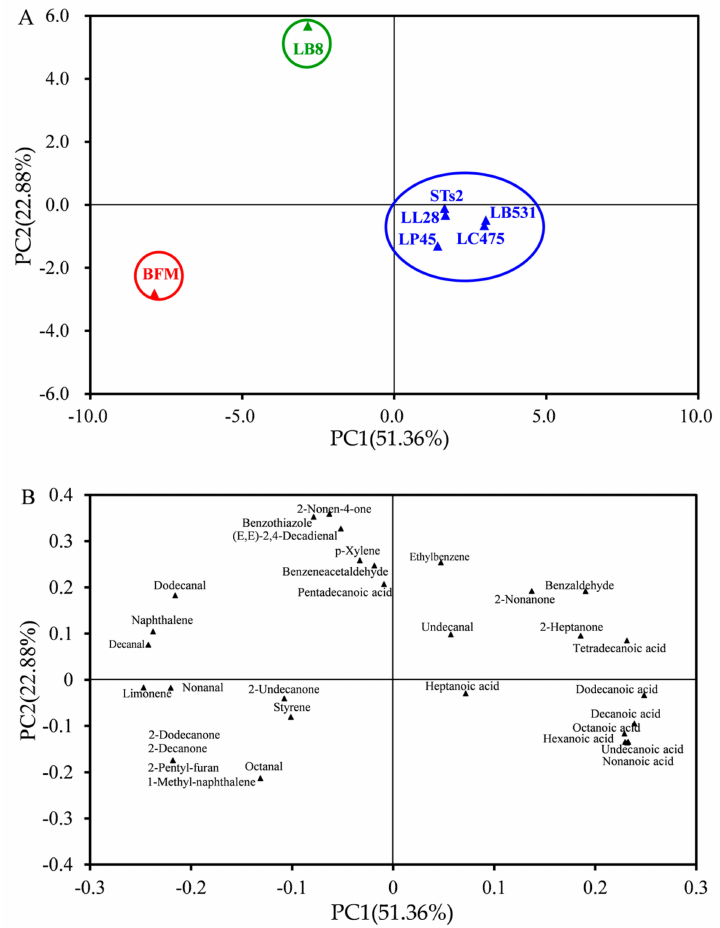
Figure 6. PCA plots from ( A ) separation of milks fermented by di ff erent starter cultures based on OAVs. ( B ) Distribution of volatile compounds in milks fermented by di ff erent starter cultures based on